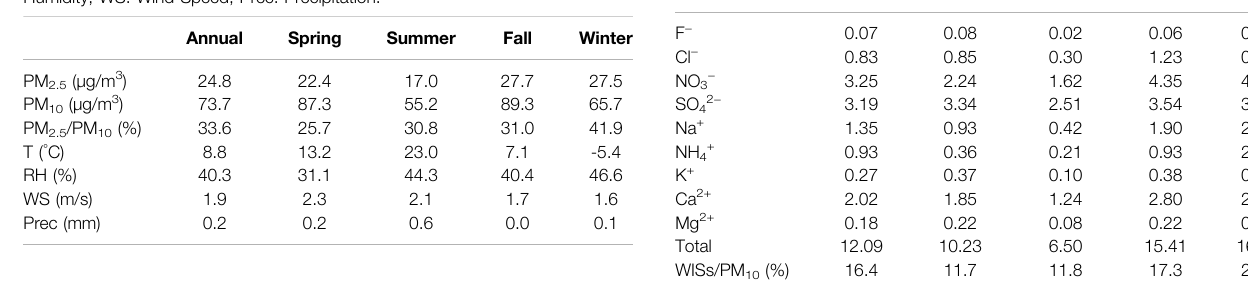
TABLE 1 | Annual mean and seasonal mean of PM 2.5 and PM 10 mass concentrations and meteorological parameters in Jiuquan city during the